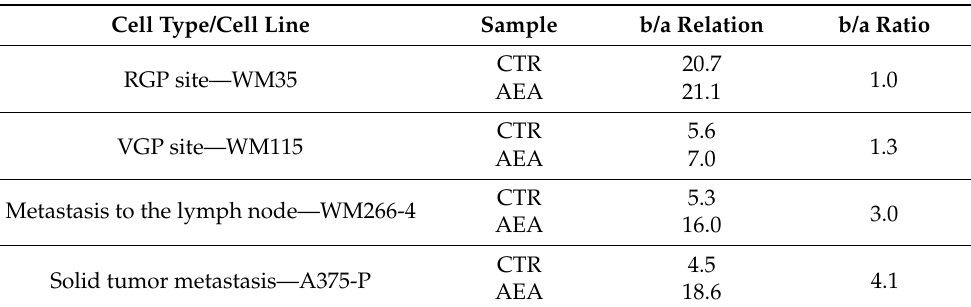
Figure 6. The results of the lectin-ELISA assay for AEA-treated and closely related (from the same patient) melanoma VGP cells (( A ) WM115 in red) and cells from the metastasis to the lymph node (( B ) WM266-4 in blue), where the fluorescent intensity was plotted as a function of the bound lectin Con A-FITC to the glycans present on the investigated cells. Table 2. Results of the lectin-ELISA analysis of the studied lectin–glycan interaction performed on AEA-treated melanoma cells. The b/a relation was calculated by using the parameters of the linear regression, where a is the slope and b the intercept. The b/a ratio was calculated as the AEA/DMSO relation.